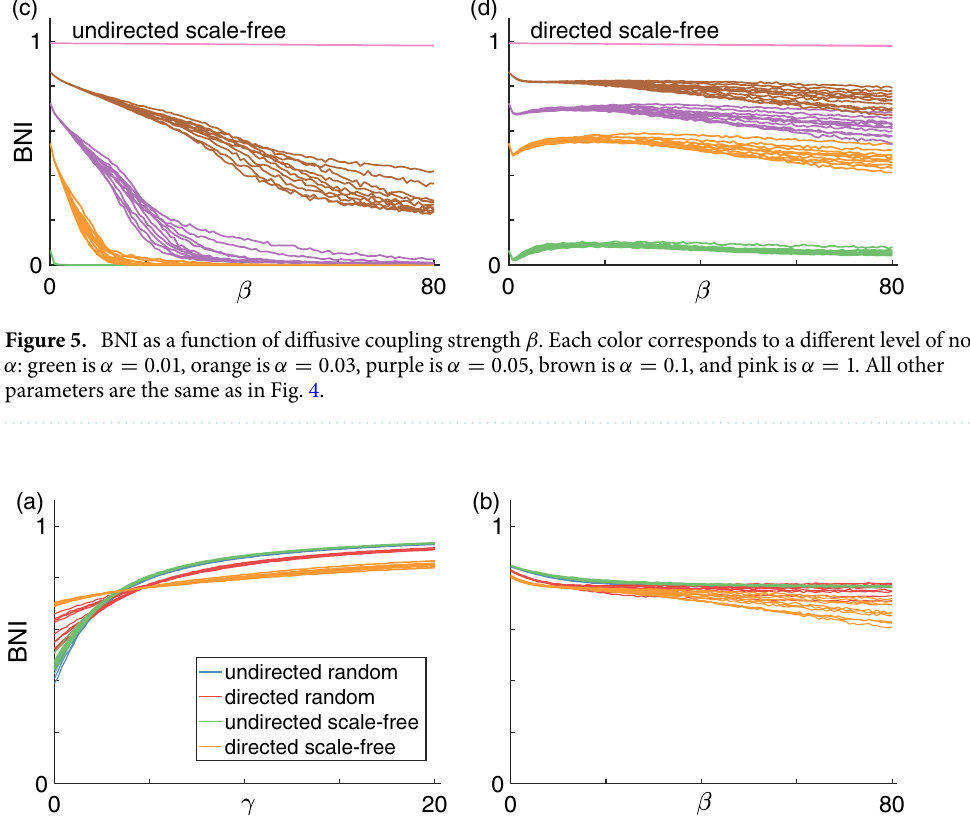
Figure 6. BNI as a function of ( a ) γ(β = 10 ) and ( b ) β(γ = 5 ) using the mixed coupling. Each color corresponds to a different network topology: blue corresponds to undirected random networks, red to directed random networks, green to undirected scale-free networks (overlaps the blue), and orange to directed scale-free networks. Each curve corresponds to a different network realisation. We fix α = 0.05 and mean degree c = 4